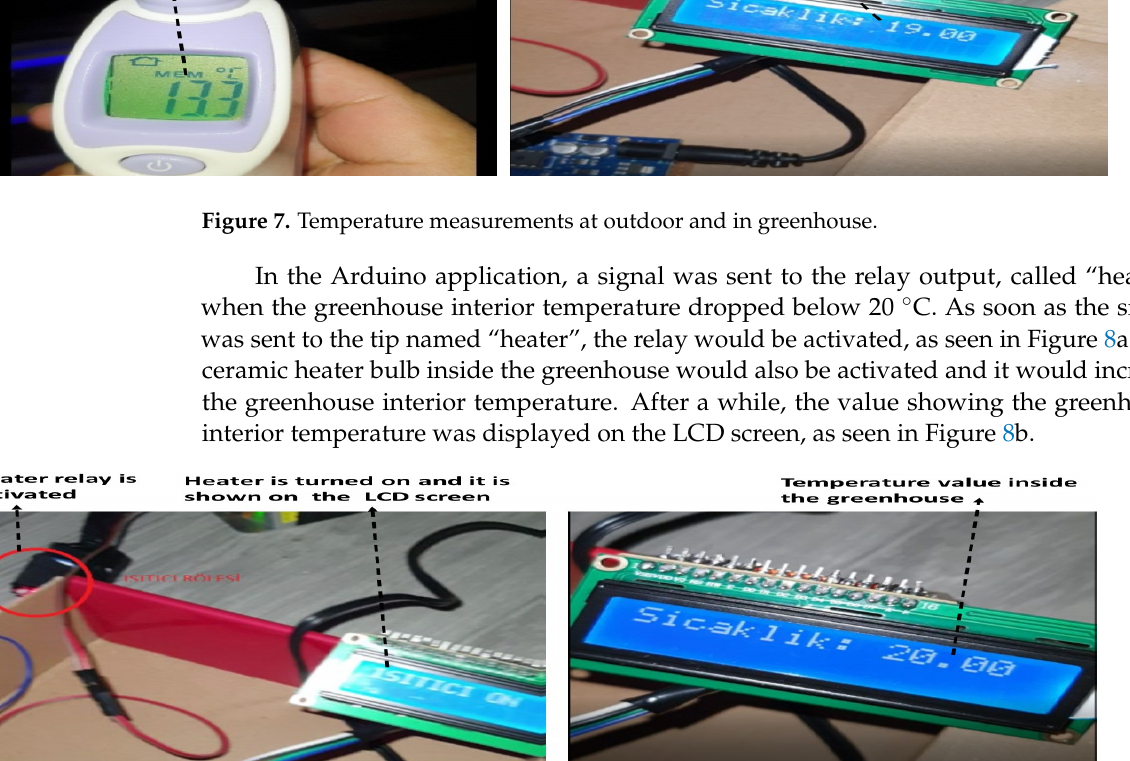
( d ) Figure 6. Developmental process of plants grown in the greenhouse ( a , b ) and in pots ( c , d ). The development stages of pot-grown plants during the entire study period are shown in Figure 6c,d.